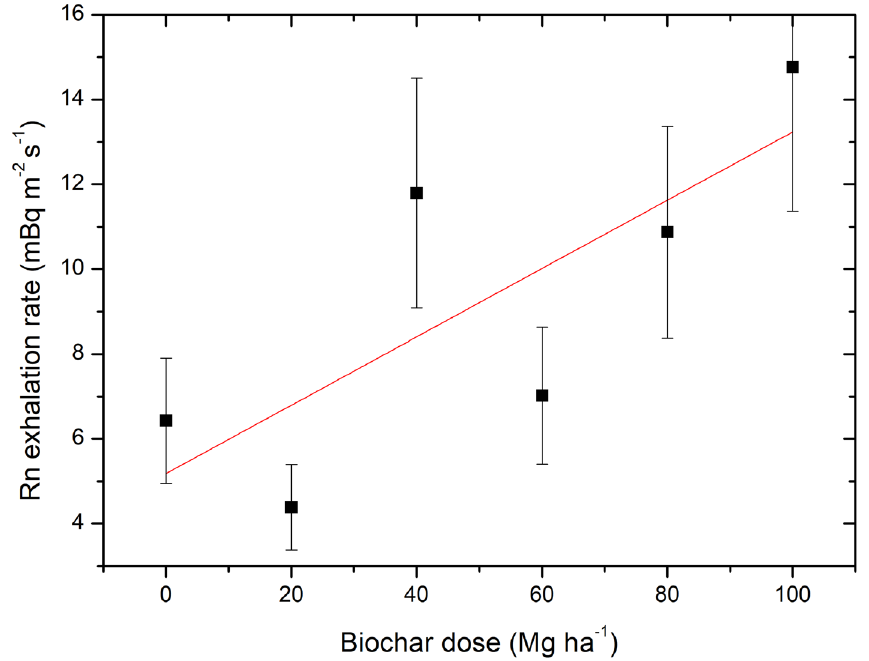
Figure 8. Radon exhalation rate (black squares) with uncertainties observed for five experimental fields and for the control one as a function of the biochar dose applied into the soil. The red line represents the increased trend associated with the